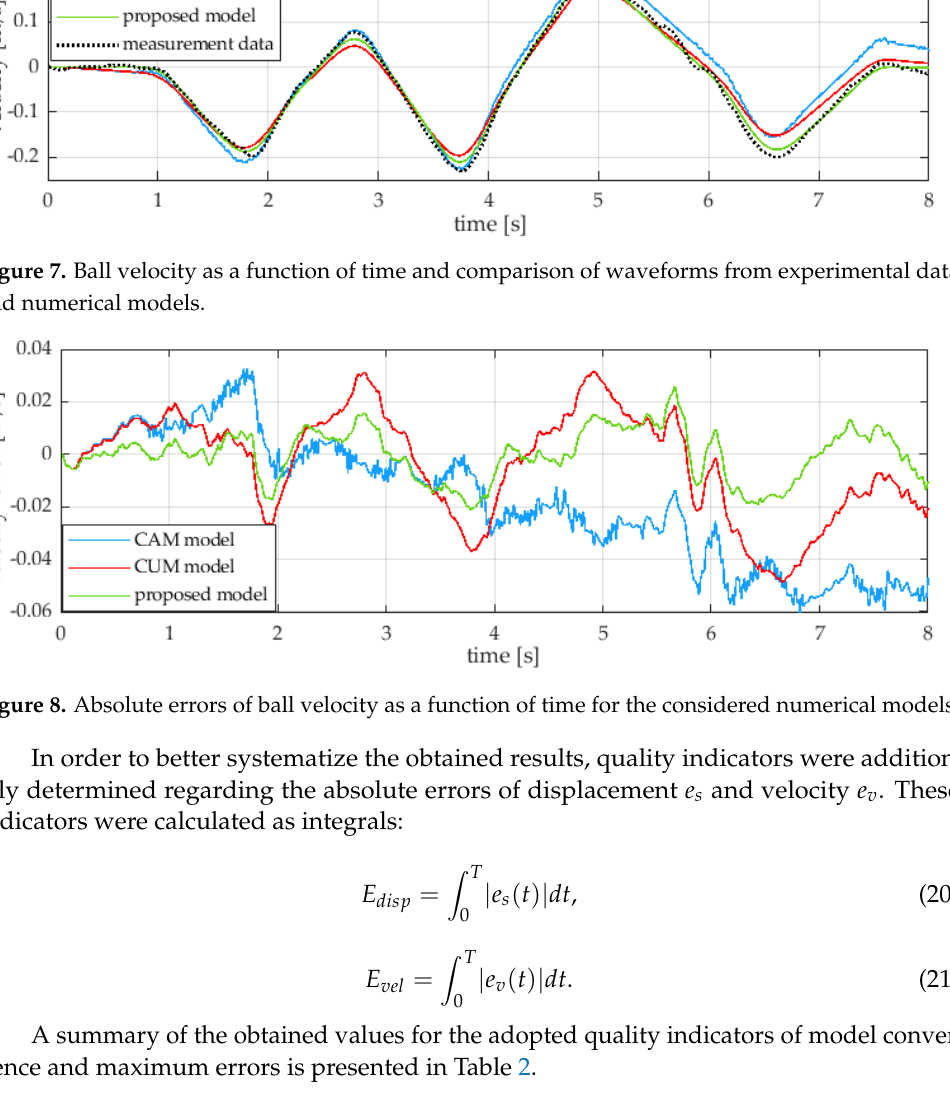
Figure 6. Absolute errors of ball displacement as a function of time for the considered numerical models.